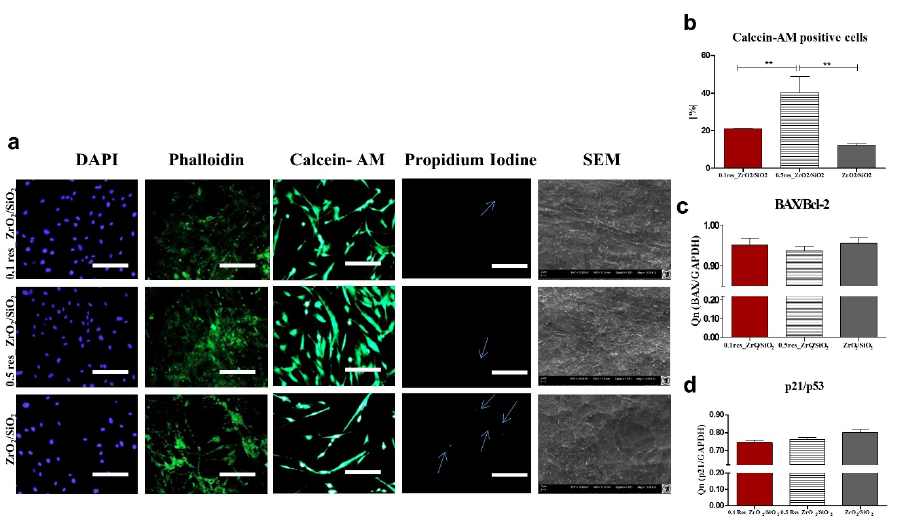
Figure 5: Morphology of ASCs evaluated with DAPI and Phalloidin (a) - two columns from the left. Additionally Calcein- AM staining indicates live cells while propidium iodide staining signalizes dead cells (a) - two columns from the right. Arrows indicate dead cells upon penetration of propidium iodide. Quantification of Clalcein-AM- Propidium iodide staining established with ImageJ software (b). The mRNA ratio of BAX/Bcl-2 (c) and p21/p53 (d) were evaluated in relation to mRNA level of housekeeping gen GAPDH. Magnification: x100. Results expressed as mean ± SD. **pvalue<0.01. Scale bar 250